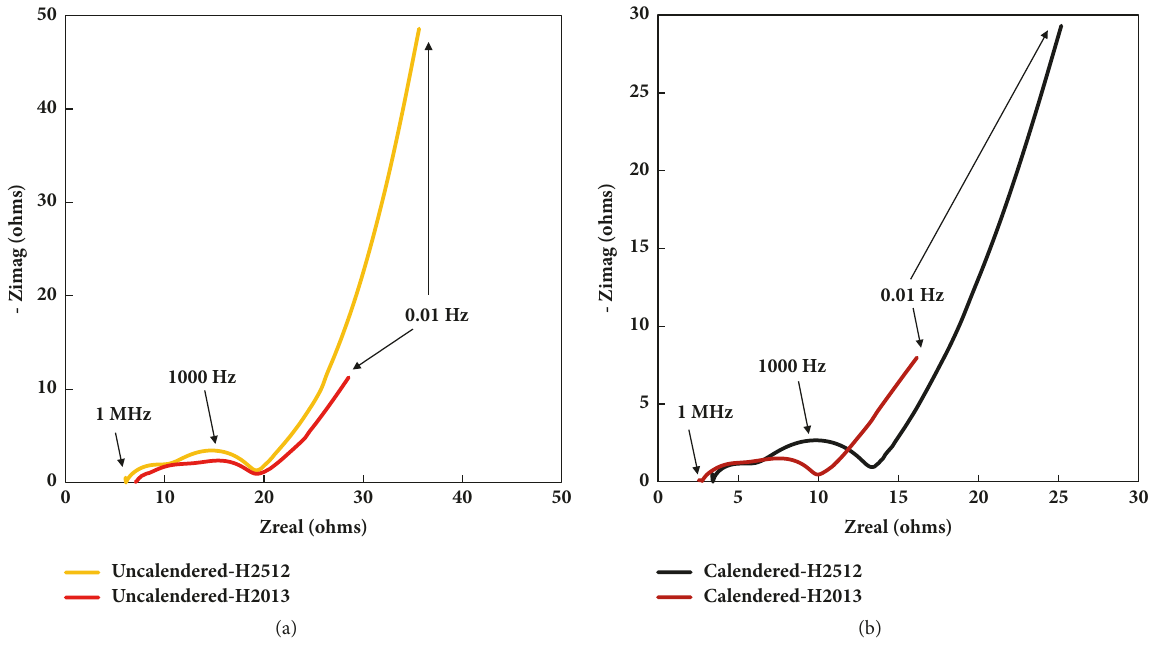
Figure 6: Measured EIS data for calendered and uncalendered electrodes for trilayer separators: (a) uncalendered electrodes using H2512 and H2013 separators; (b) calendered electrodes using H2512 and H2013